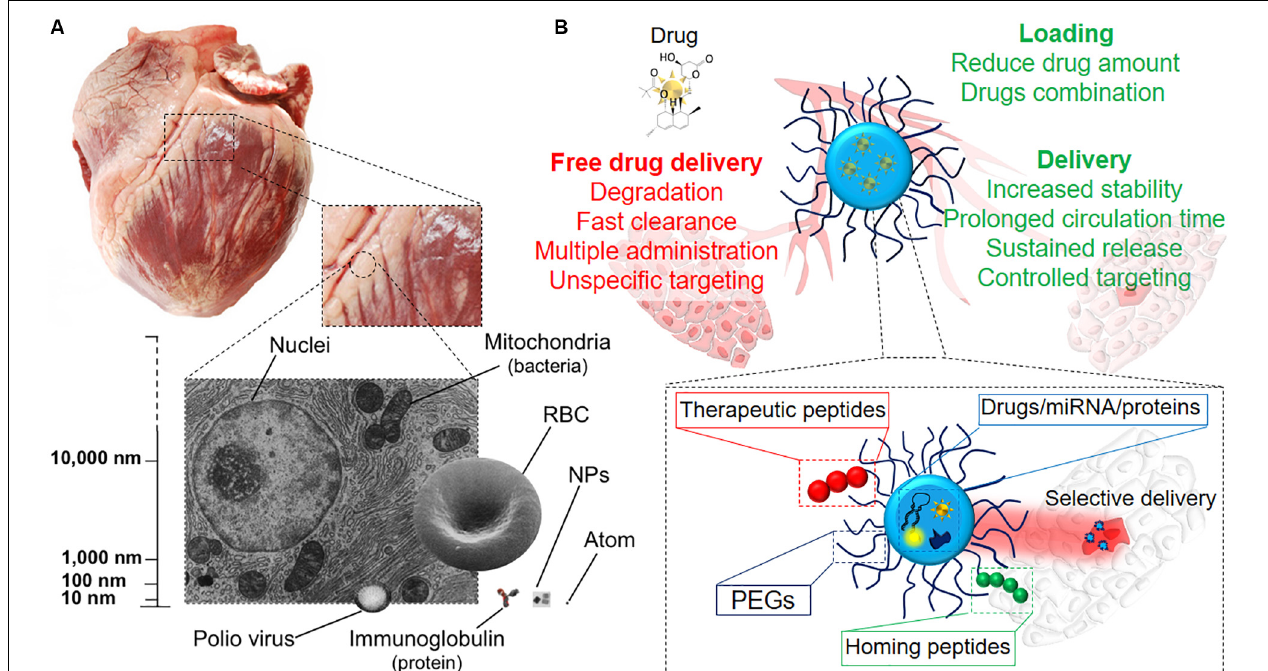
FIGURE 3 | Therapy at the nanoscale. (A) Representation of the nanosize, scaling down from the organ size (swine heart) to single cells and intracellular organelles, the latter being the group in which NPs are included. (B) Illustrative scheme of the different modalities of drug delivery. NPs as drug delivery systems have plenty of advantages if compared to systemic drug administration, such as targeted release and dosage reduction, thanks to the combination of several functional blocks within the same tool.